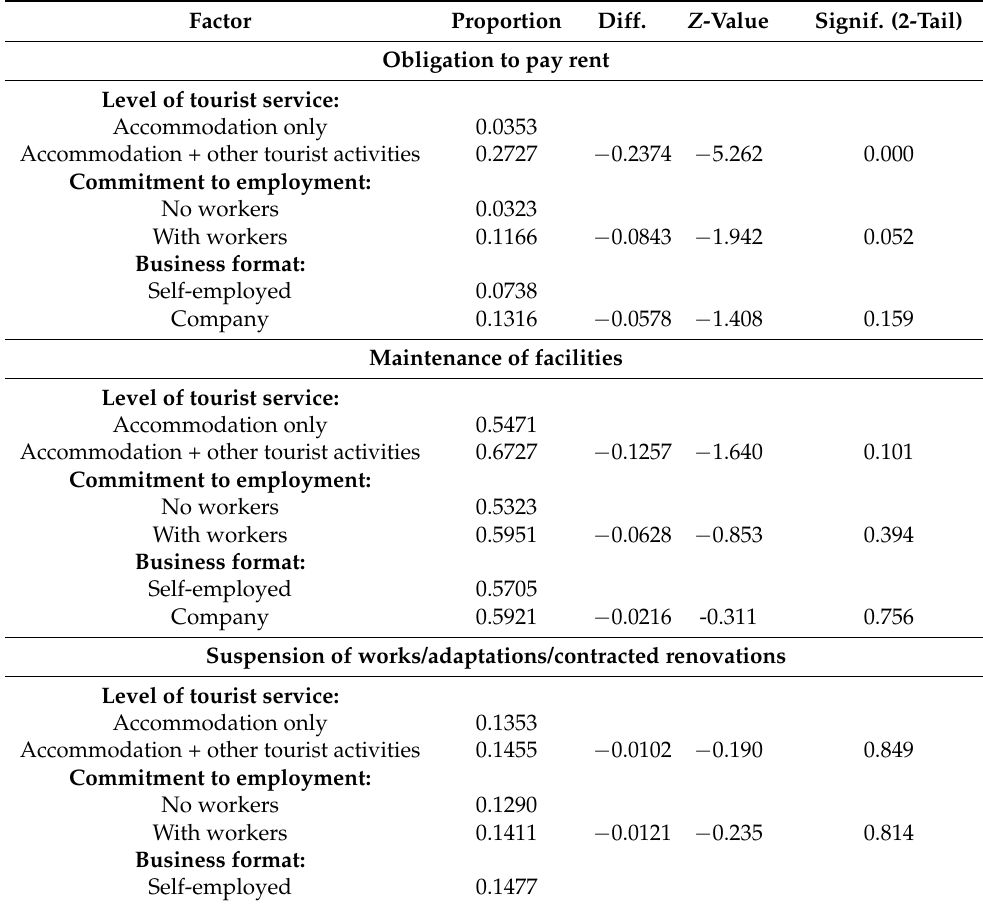
Table 5. Comparison of proportions of the effects of the COVID-19 lockdown on the tourism management of tourist accommodations C: facilities